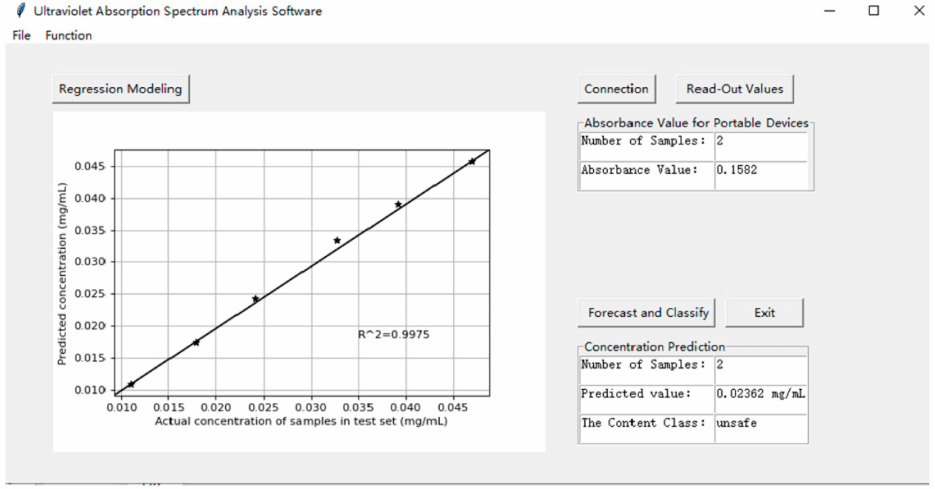
Figure 6. Content prediction results of the test set on GUI platform of portable detection